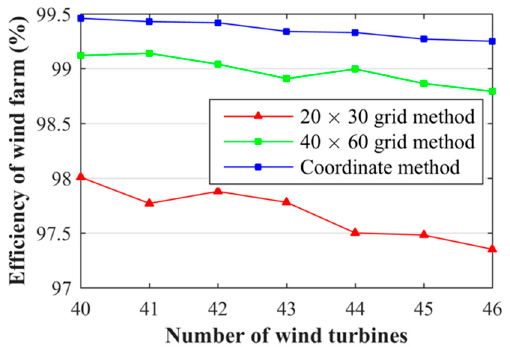
Figure 5. Wind farm efficiency results for different design methods.